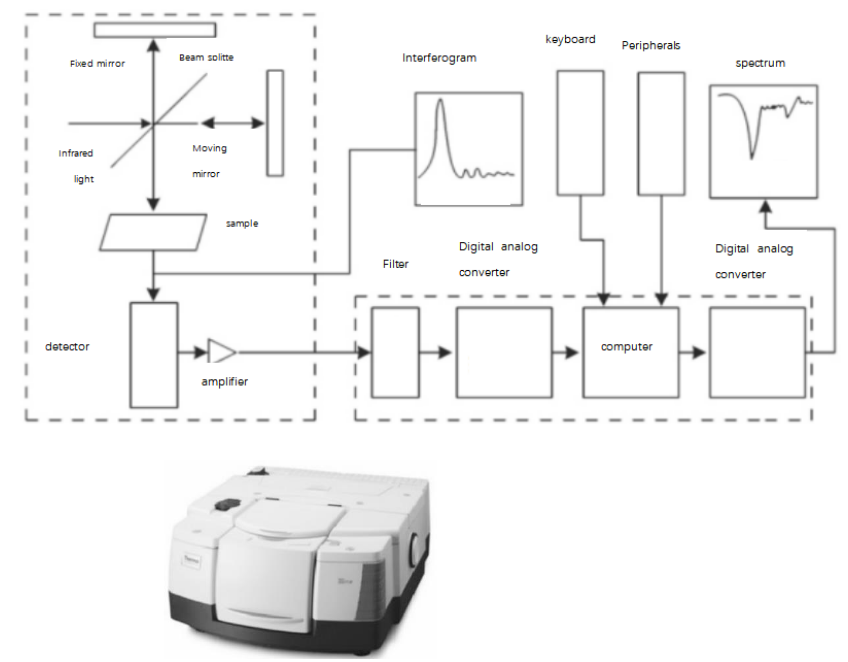
Figure 4. Measuring principle of Fourier infrared